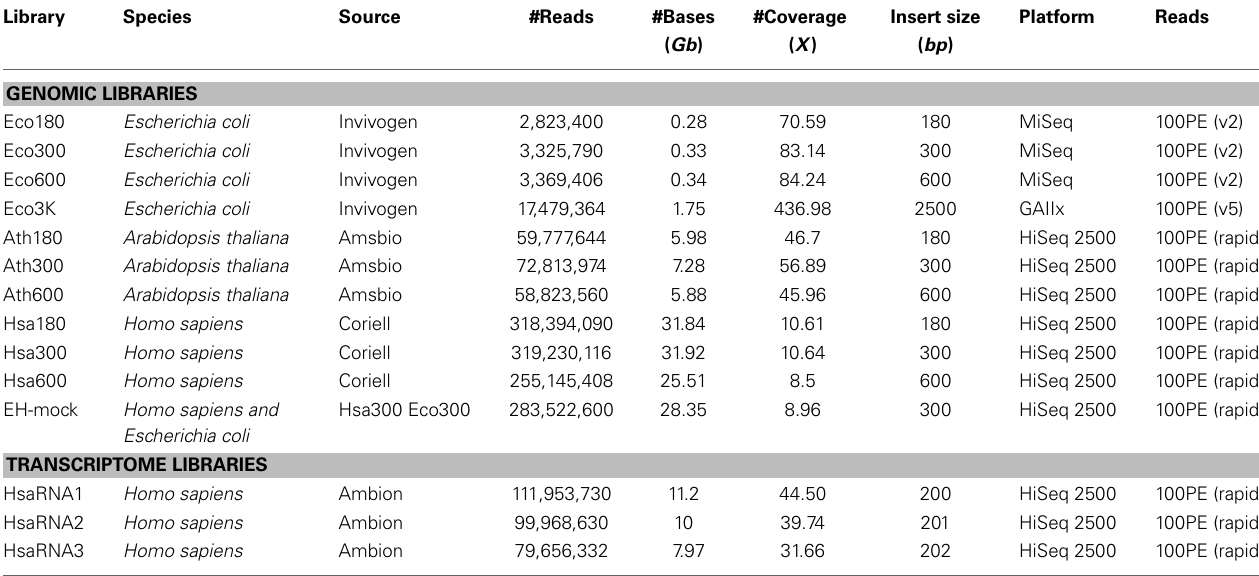
Table 1 | Summary of benchmark